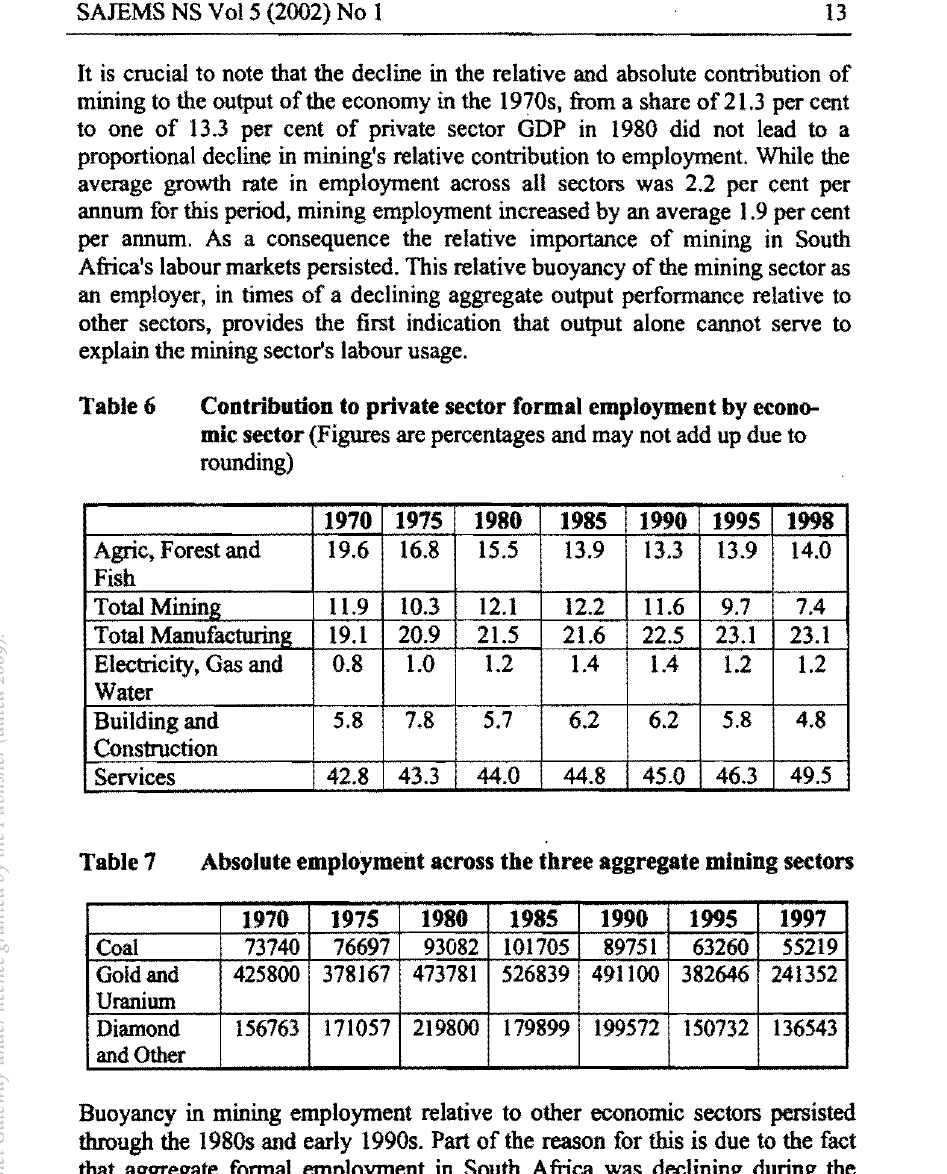
Absolute employment across the three aggregate mining sectors